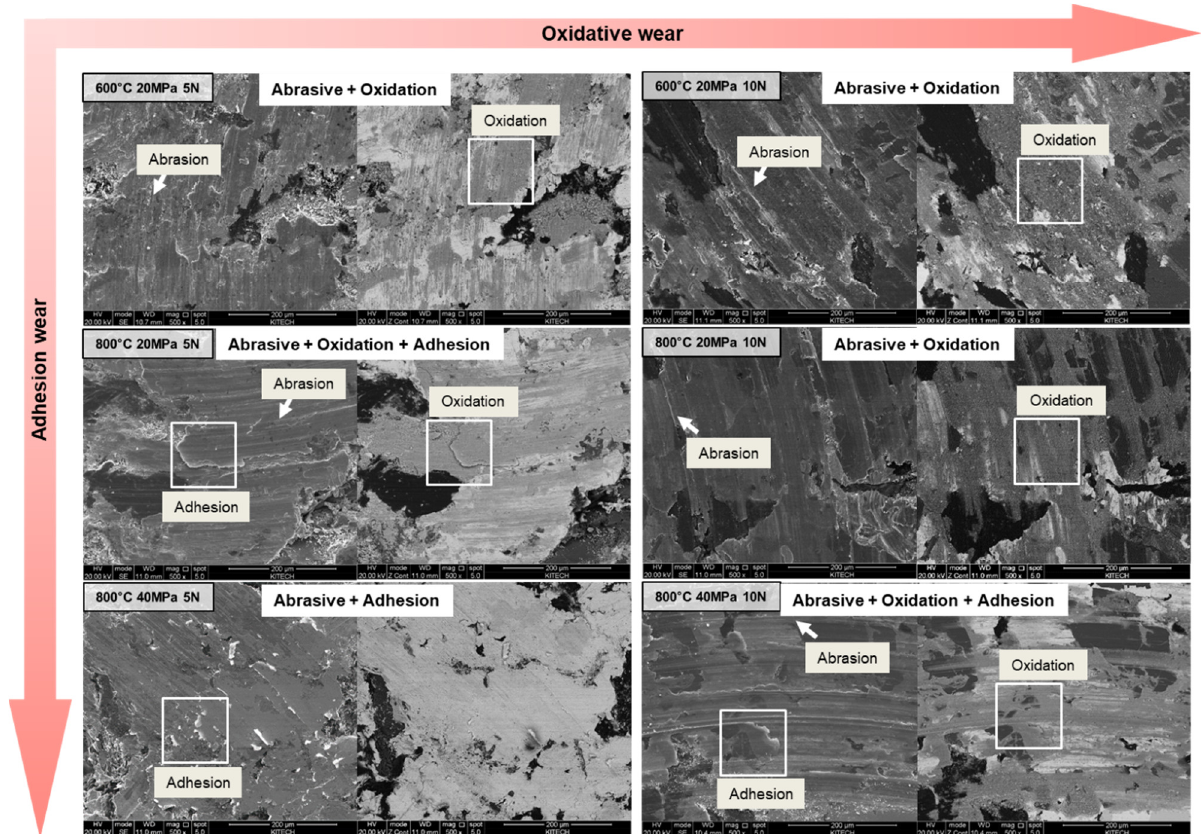
Figure 11. Wear mechanism of samples formed under different SPS conditions.